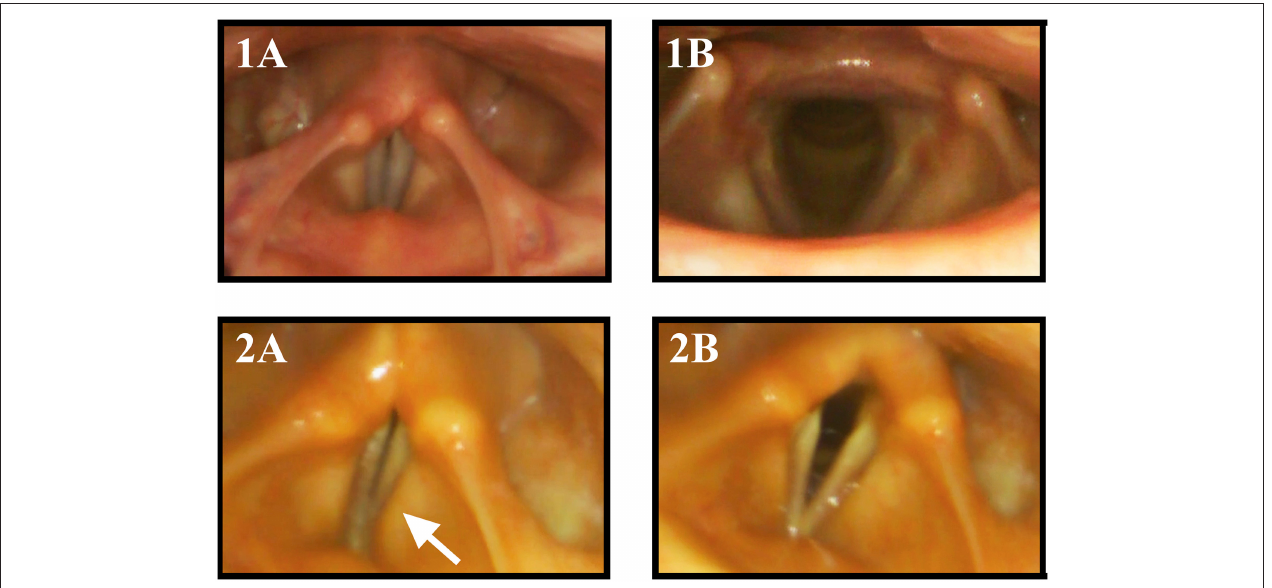
FIGURE 2 | Vocal fold motion during laryngeal tasks in a healthy control subject and a MSA patient: 1 healthy control, 2 MSA patient, (1A) phonation “eeee,” (1B) sniff. The MSA patient exhibits VFMI with insufficient vocal fold adduction and activation of the vestibular folds (arrow) during phonation (2A) and incomplete VF abduction during sniffing maneuver (2B)